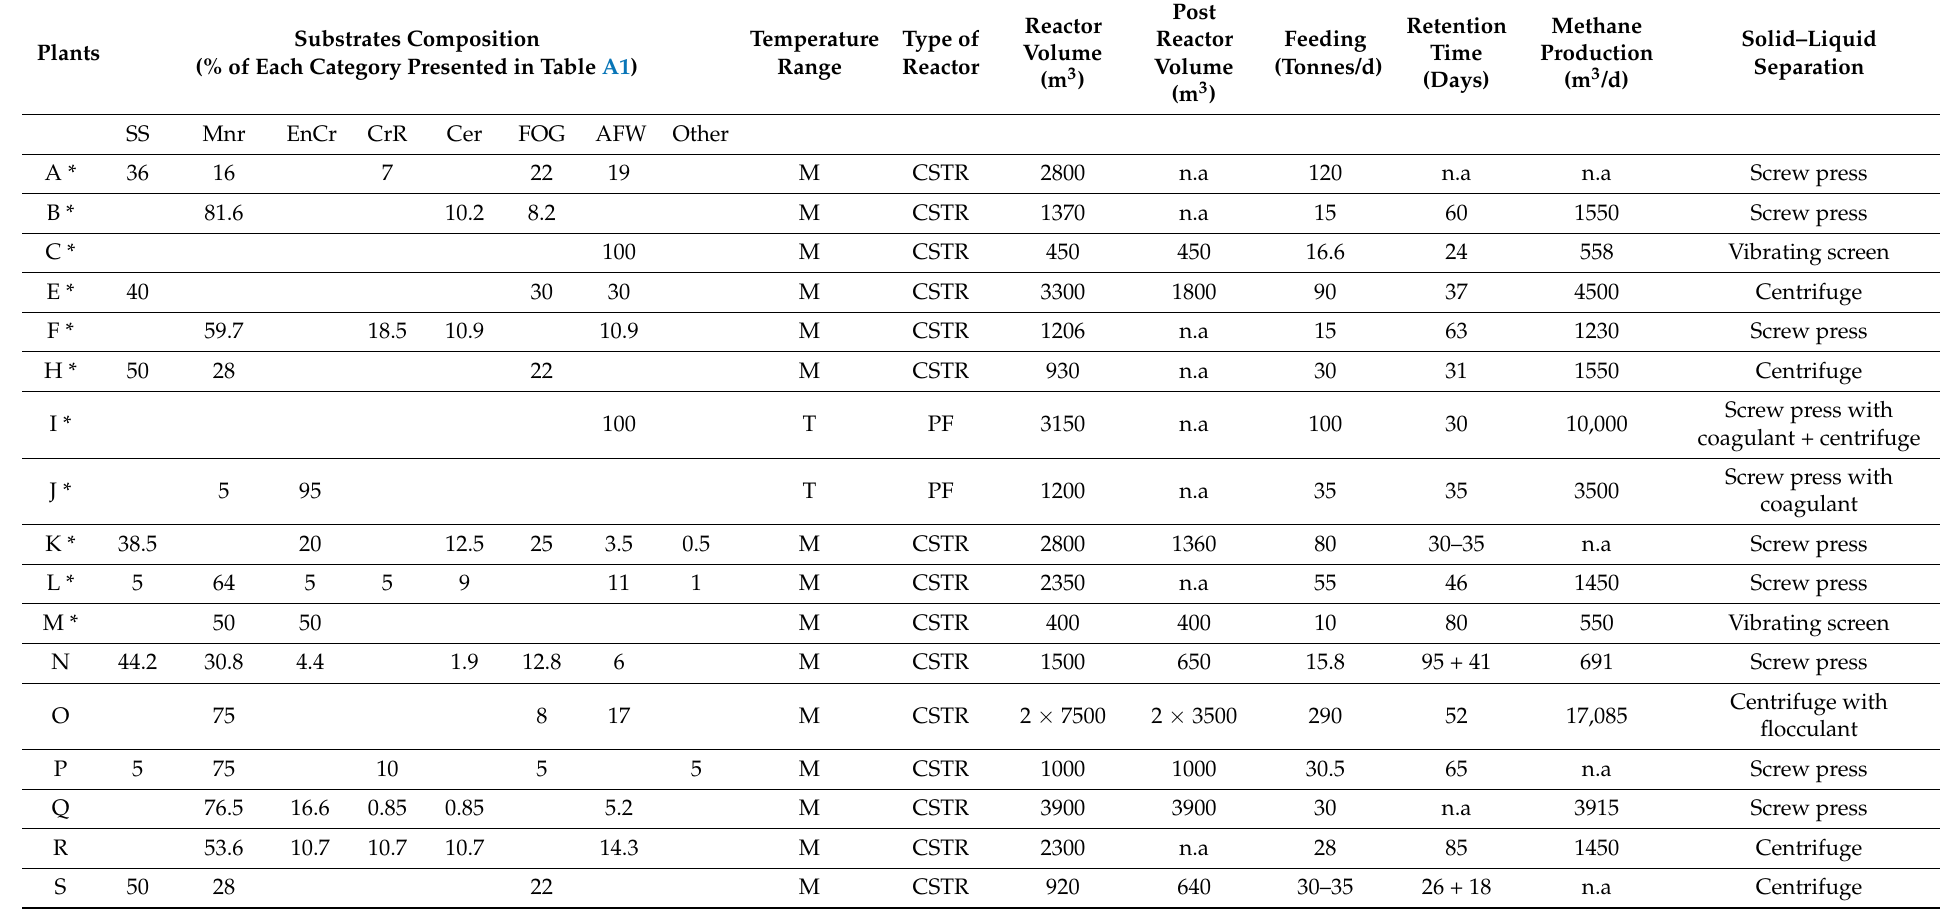
Table 1. Feedstock compositions, process parameters (temperature range, type of reactor, size of reactor, size of post reactor, feeding, retention time), methane production and types of solid–liquid